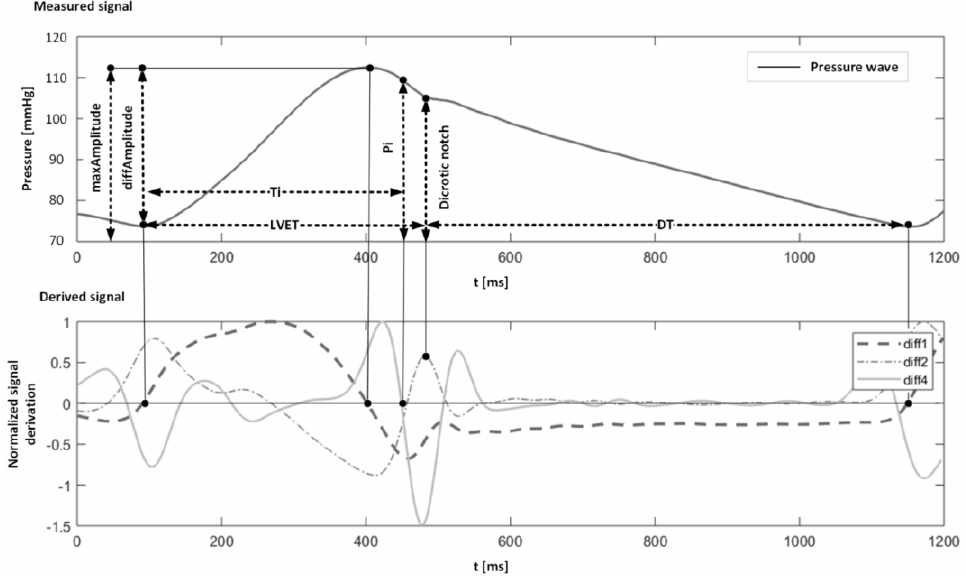
Figure 7. Example of features in pulse wave analysis [186] CC by 4.0.